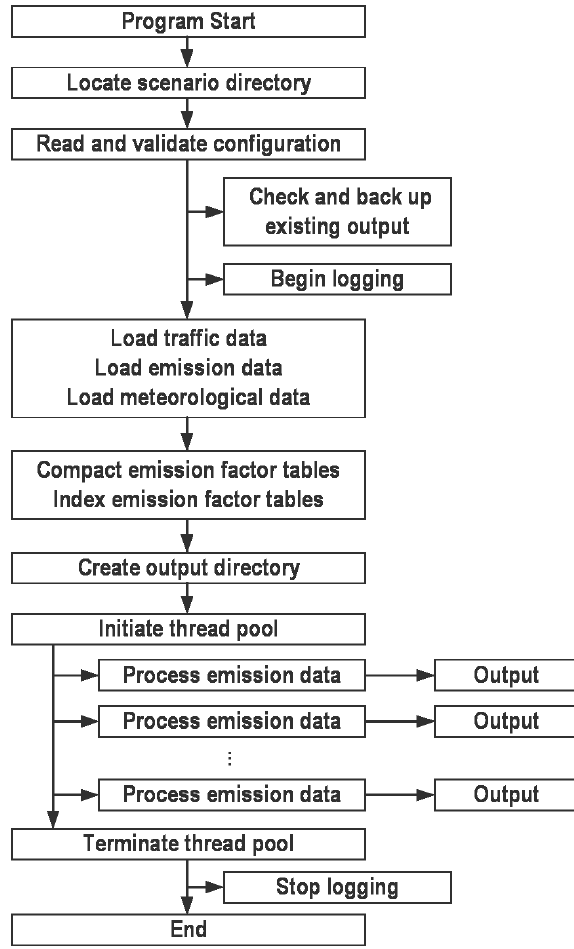
Figure 2. Execution flow of